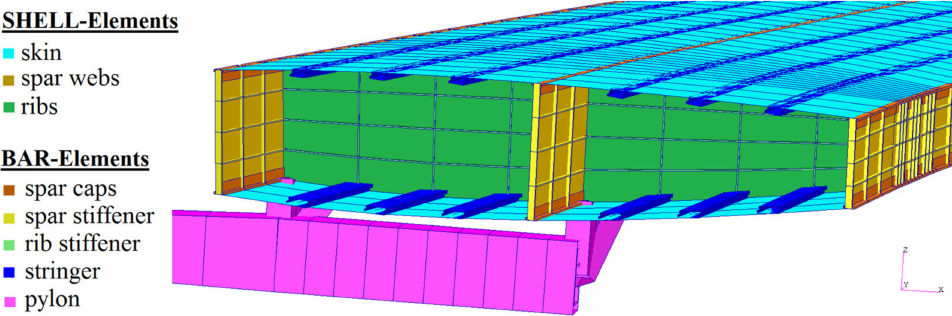
Figure 6. Wing topology of the generated wing FE-model with the applied